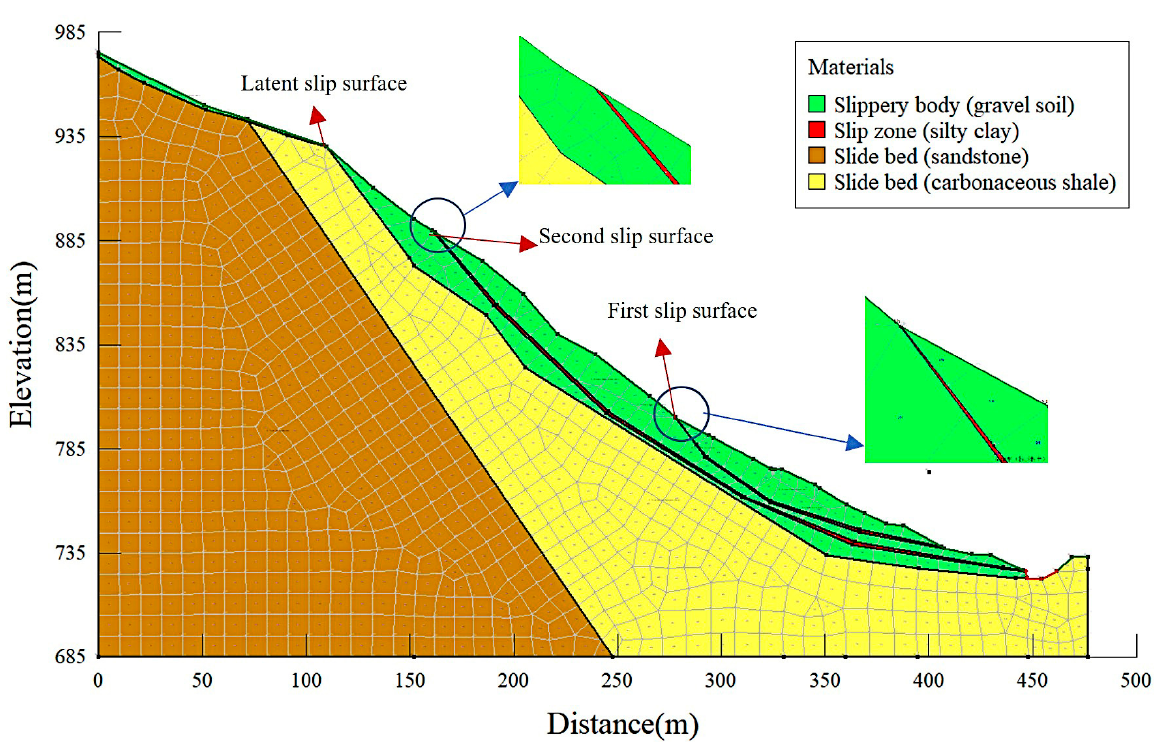
Table 5. Physical and mechanical parameters of rock and soil mass in the Siwan village landslide of Profile 2-2.